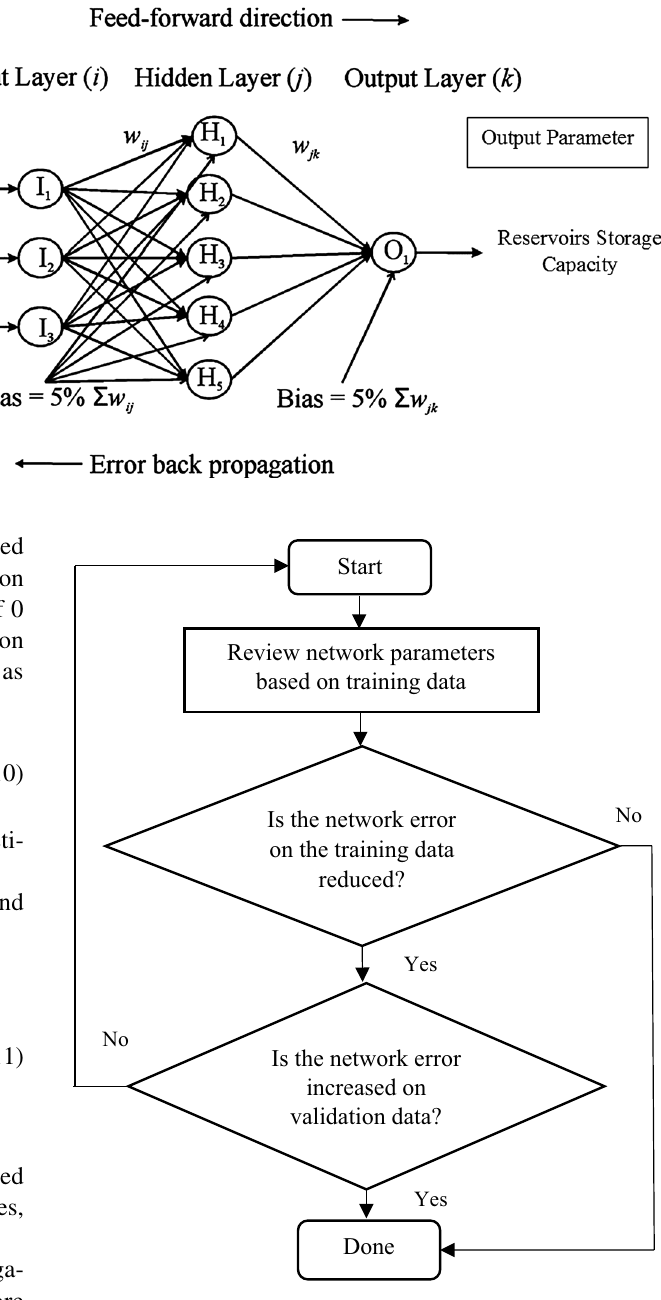
Fig. 9 The early stopping method used in ANN model